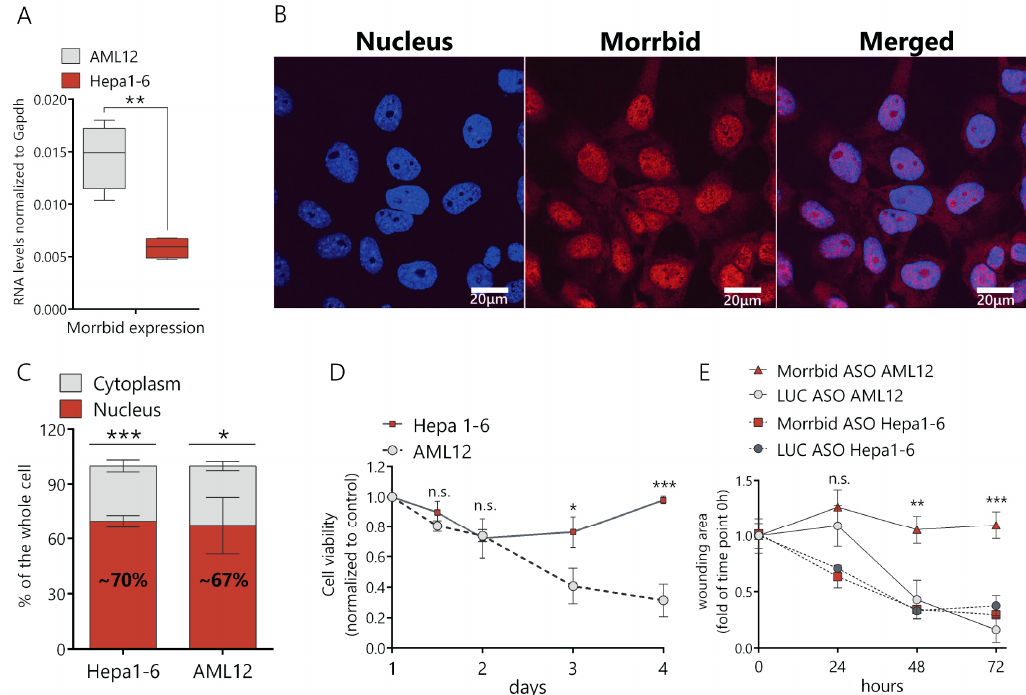
Figure 1. Characterization of Morrbid long noncoding RNA (lncRNA) expression, cellular localization and knockdown phenotype. ( A ) Comparison of Morrbid expression levels in AML12 normal murine hepatocytes and the Hepa1-6 hepatoma cell line with RT-qPCR. ( B ) Fluorescence in situ hybridization analysis (FISH) of Morrbid localization in AML12 cells (DNA was stained with Dapi and Morrbid was stained with a Cy5-labeled probe). ( C ) RT-qPCR analysis of Morrbid expression in the nuclear and cytoplasmic fractions extracted from AML12 cells. ( D ) Viability assay of Hepa1-6 and AML12 cells depleted in Morrbid, on the 1, 1.5, 2, 3 and 4 days of knockdown, normalized to control the luciferase antisense oligonucleotides (LUC ASO) treatment and viability at day 1 after the initial transfection. ( E ) Wound-healing assay of Morrbid knockdown (KD) and LUC control KD in AML12 and Hepa1-6 cells. The wound was introduced just after the initial transfection, and data were normalized to the wound area at the first timepoint. Results show mean ± SD. n.s.—not significant. * p < 0.05, ** p < 0.01 and *** p < 0.001.